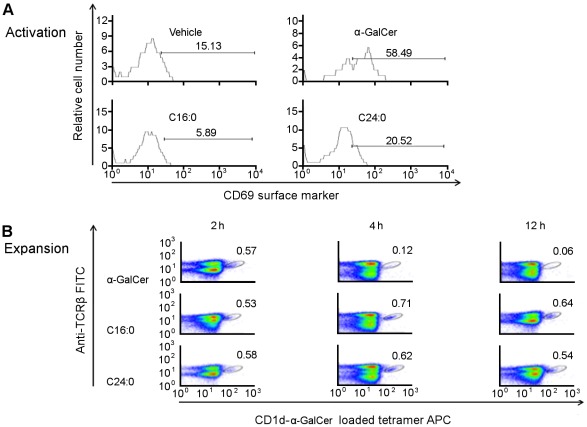
Analyses of sulfatide-induced stimulation of the activation and expansion of type I iNKT cells.(A) C16:0 and C24:0 do not stimulate the activation of type I iNKT cells. At 2 h after female NOD mice (3–5 week-old, n = 5/group) were injected (i.p.) with vehicle (PBS), aGalCer (5 mg) or sulfatide (C16:0 or C24:0, 100 mg), their splenocytes were analyzed by FACS for the surface expression of the early activation surface marker CD69 on TCRβ+a-GalCer/CD1dTet+ iNKT cells. (B) C16:0 and C24:0 do not stimulate the expansion of type I iNKT cells. At 2 h, 4 h and 12 h after female NOD mice (3–5 week-old, n = 5/group) were injected (i.p.) with either control vehicle (PBS), aGalCer (4 mg) or sulfatide (C16:0 or C24:0, 100 mg), splenocytes were analyzed by FACS for the expansion of TCRb+a-GalCer/CD1dTet+ iNKT cells. Data shown in (A) and (B) were obtained from one of two representative and reproducible experiments.